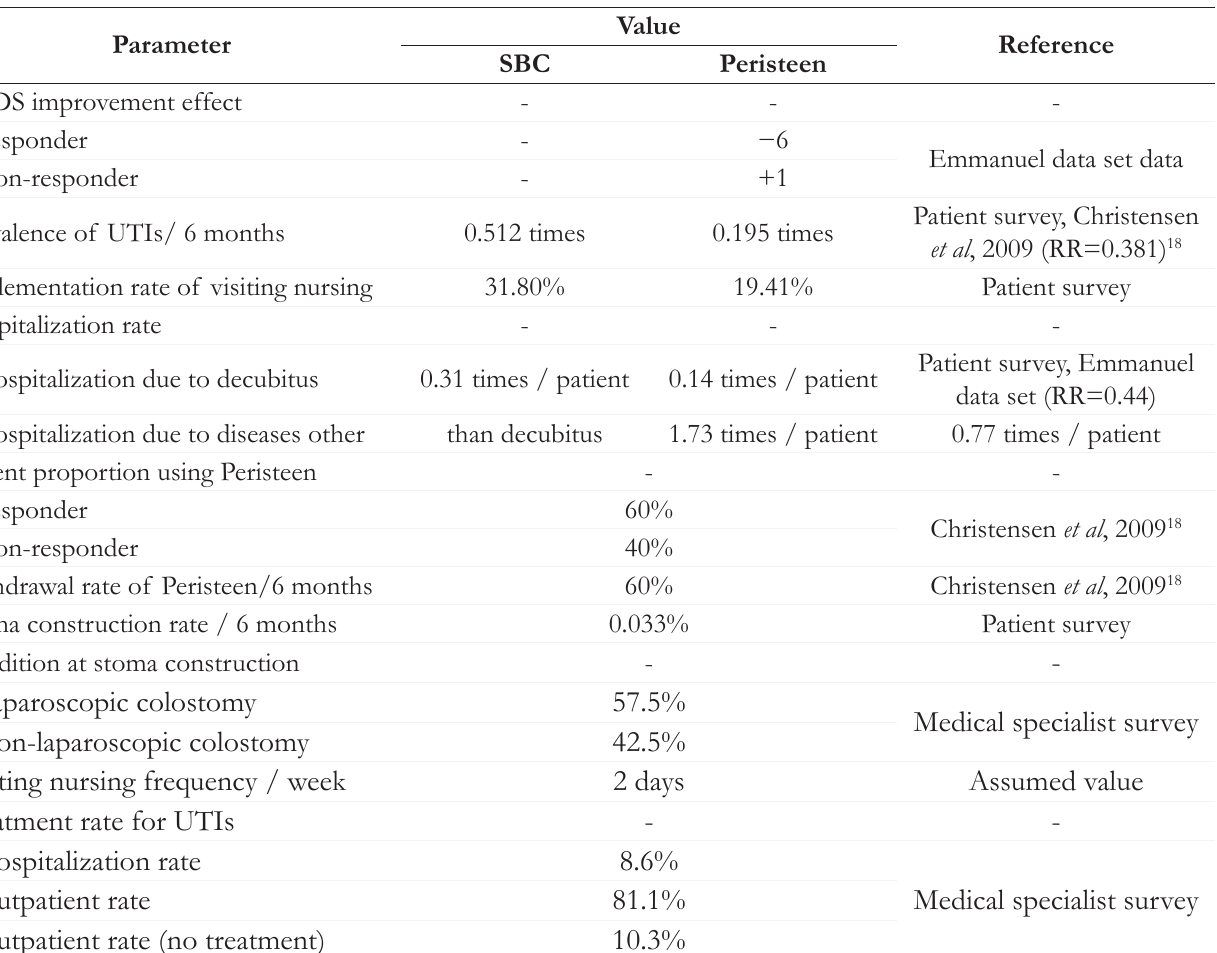
Table 2. Clinical